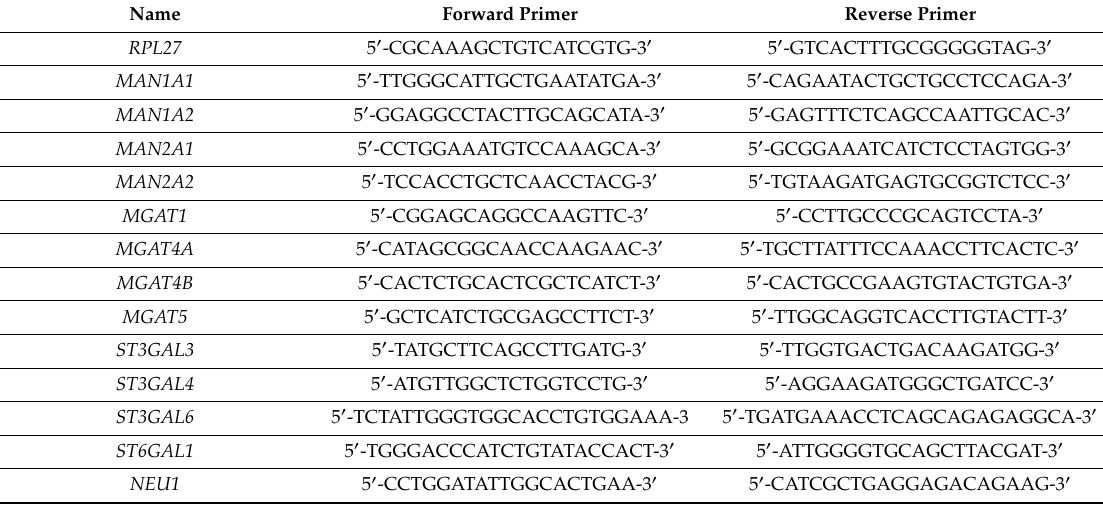
Table 4. Primer sequences used in the study for the mRNA amplification of glycosylation